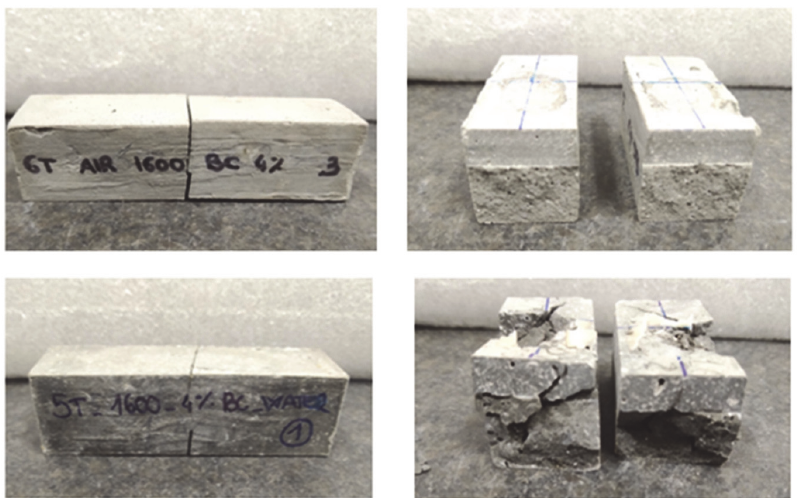
Figure 8: Fracture path and fracture surface of four analyzed foamed concrete notched beams with 4% biochar cured in air (top) and in water